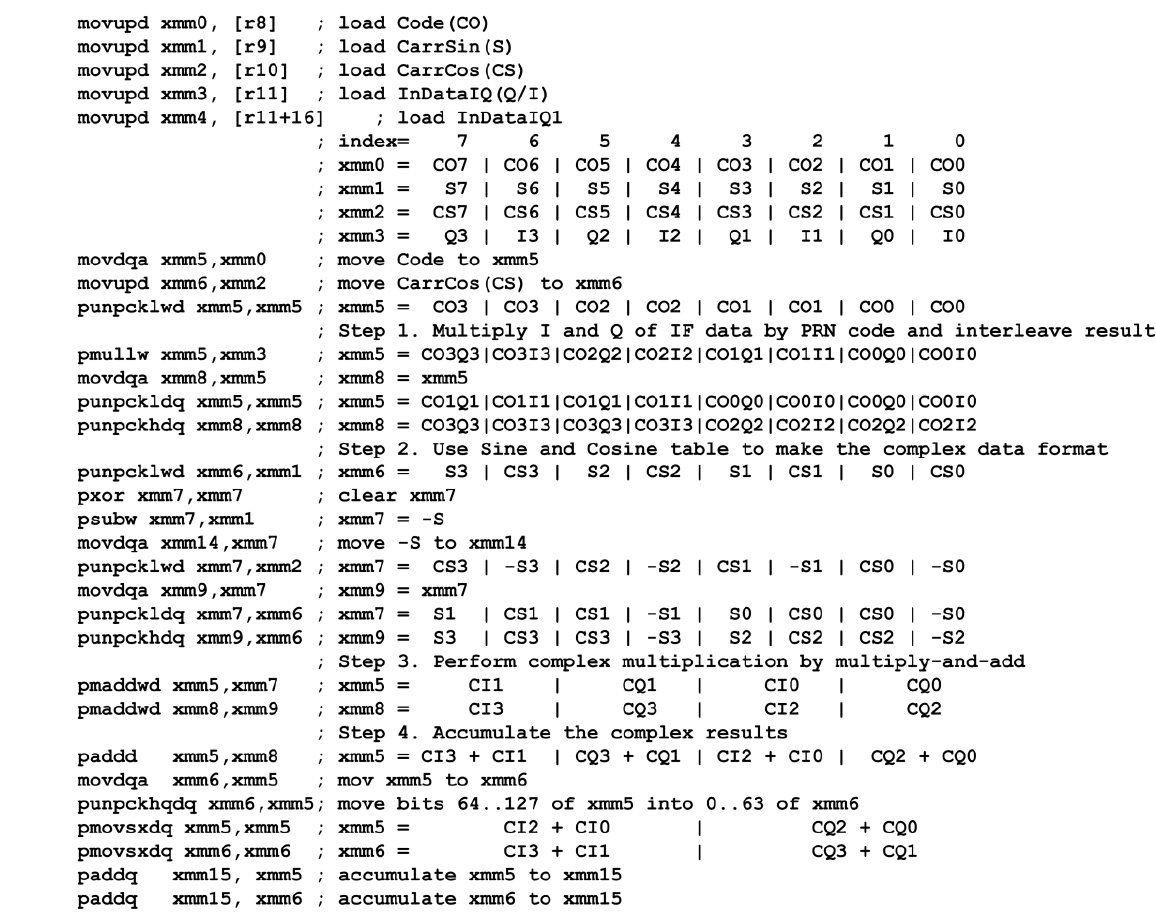
Figure 8. Assembly code example of software correlator using SIMD